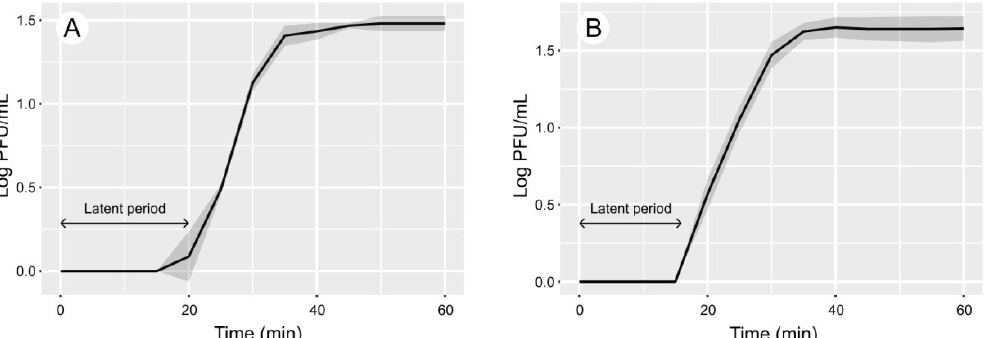
Figure 1. The length of the latent period in the development of bacteriophages assessed by one-step growth experiments. ( A ) Enterococcus phage GVEsP-1. ( B ) Enterococcus phage SSsP-1. The shaded areas delineate standard deviation in three biological replicates.